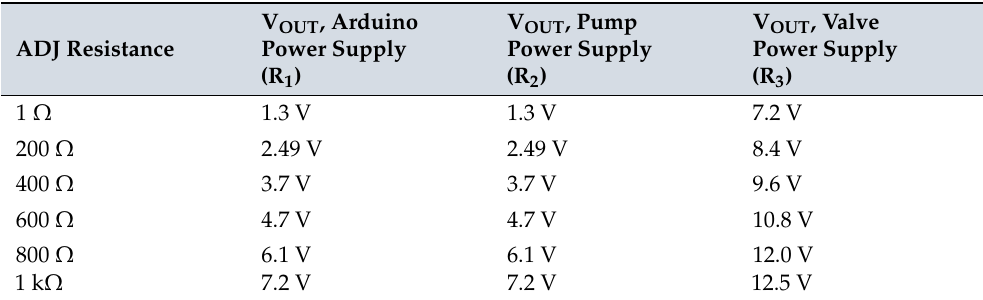
Table 1. LTSpice simulation data, showing the voltage regulator output voltage for all three main blocks of the electronic circuit. ADJ Resistance